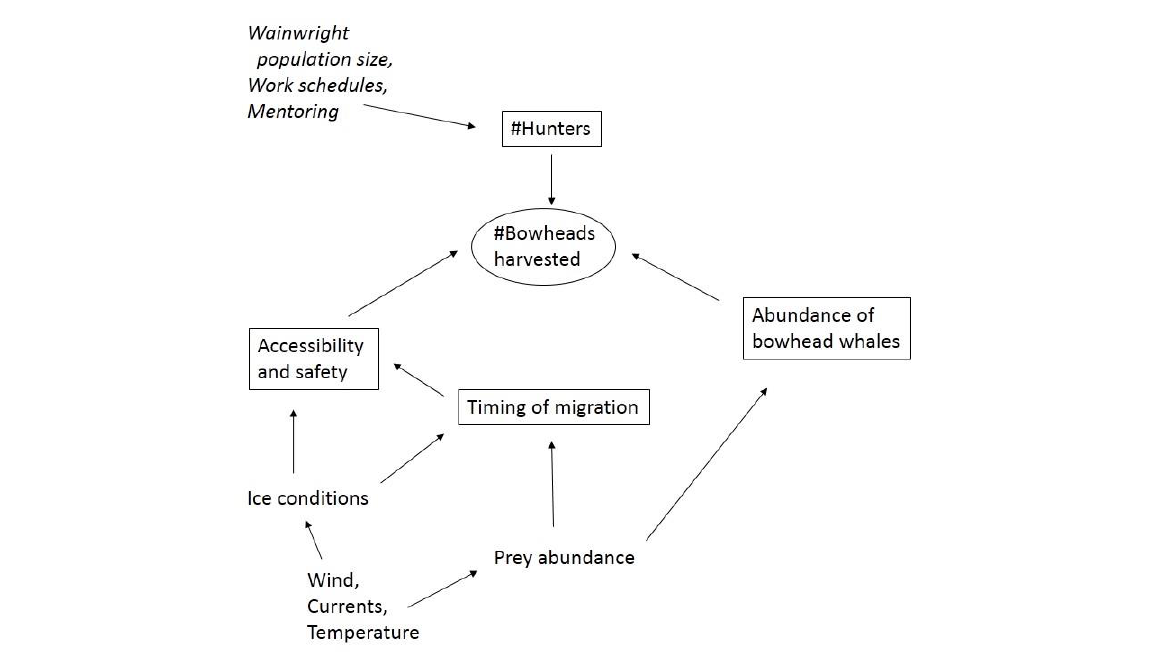
Figure A1.2. Model of bowhead whale subsistence system in Wainwright, Alaska